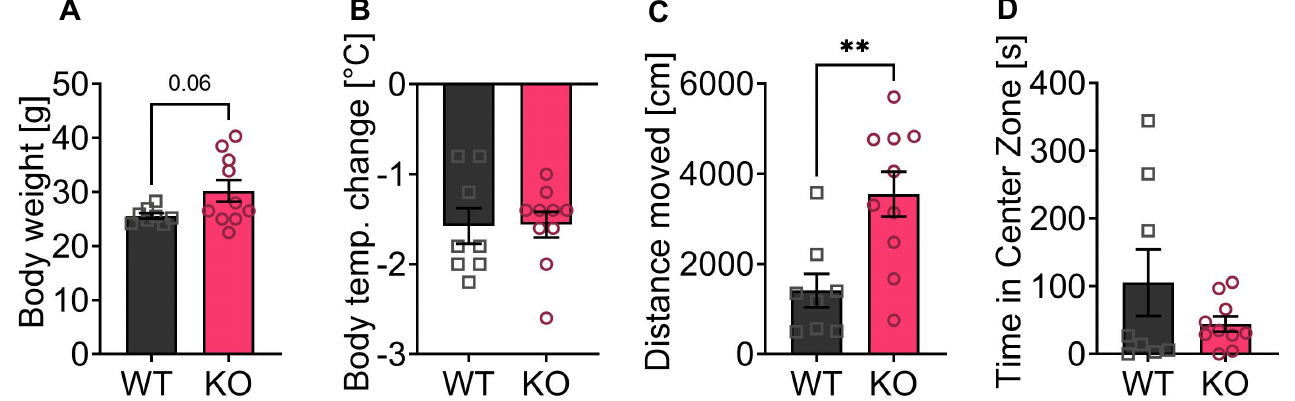
Figure 6. Reduced locomotor effects of THC administration in p62 KO mice. ( A ) Body weight of p62 KO mice was slightly increased compared to WT mice ( p = 0.06). ( B ) Body temperature 30 min after THC injection showed no significant difference between genotypes. ( C ) The distance traveled in open field 30 min after injection was significantly reduced in WT mice compared to p62 KO littermates (vehicle and THC 5 mg/kg). ( D ) The distance traveled in the center of the open field arena 30 min after THC injection was comparable between genotypes (THC 5 mg/kg). ** p < 0.01 (unpaired t -test). All error bars show mean ± SEM. Squares and circles represent single replicates. Age: 7–8 months old, female, WT N = 8; KO N =